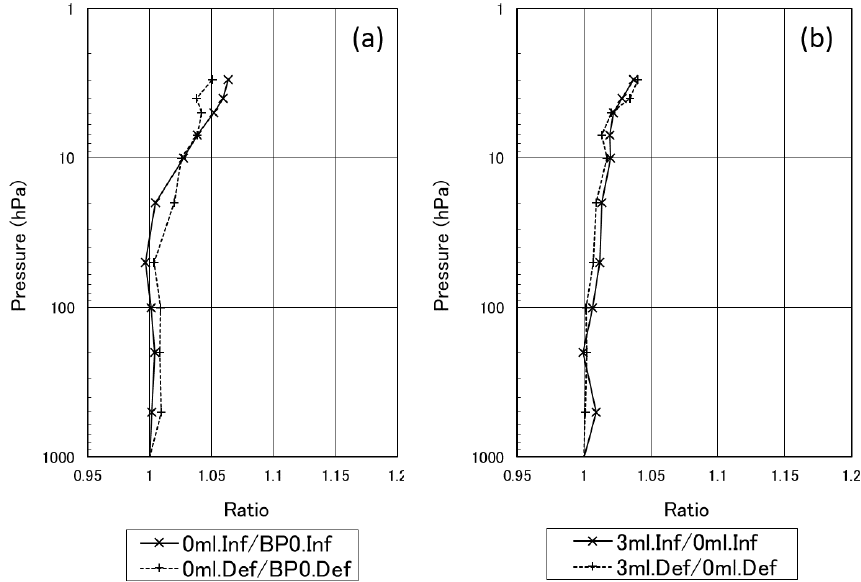
Figure 8. (a) Ratio of pump efficiency with a direct connection to the flowmeter from the pump exhaust port and through an empty reaction cell. (b) Ratio of pump efficiency between an empty reaction cell and one with the standard 3mL of ECC silicon oil. Inf: inflation; Def: deflation; BP0: back-pressure 0hPa; 0mL: no reaction solution; 3mL: 3mL of reaction solution.